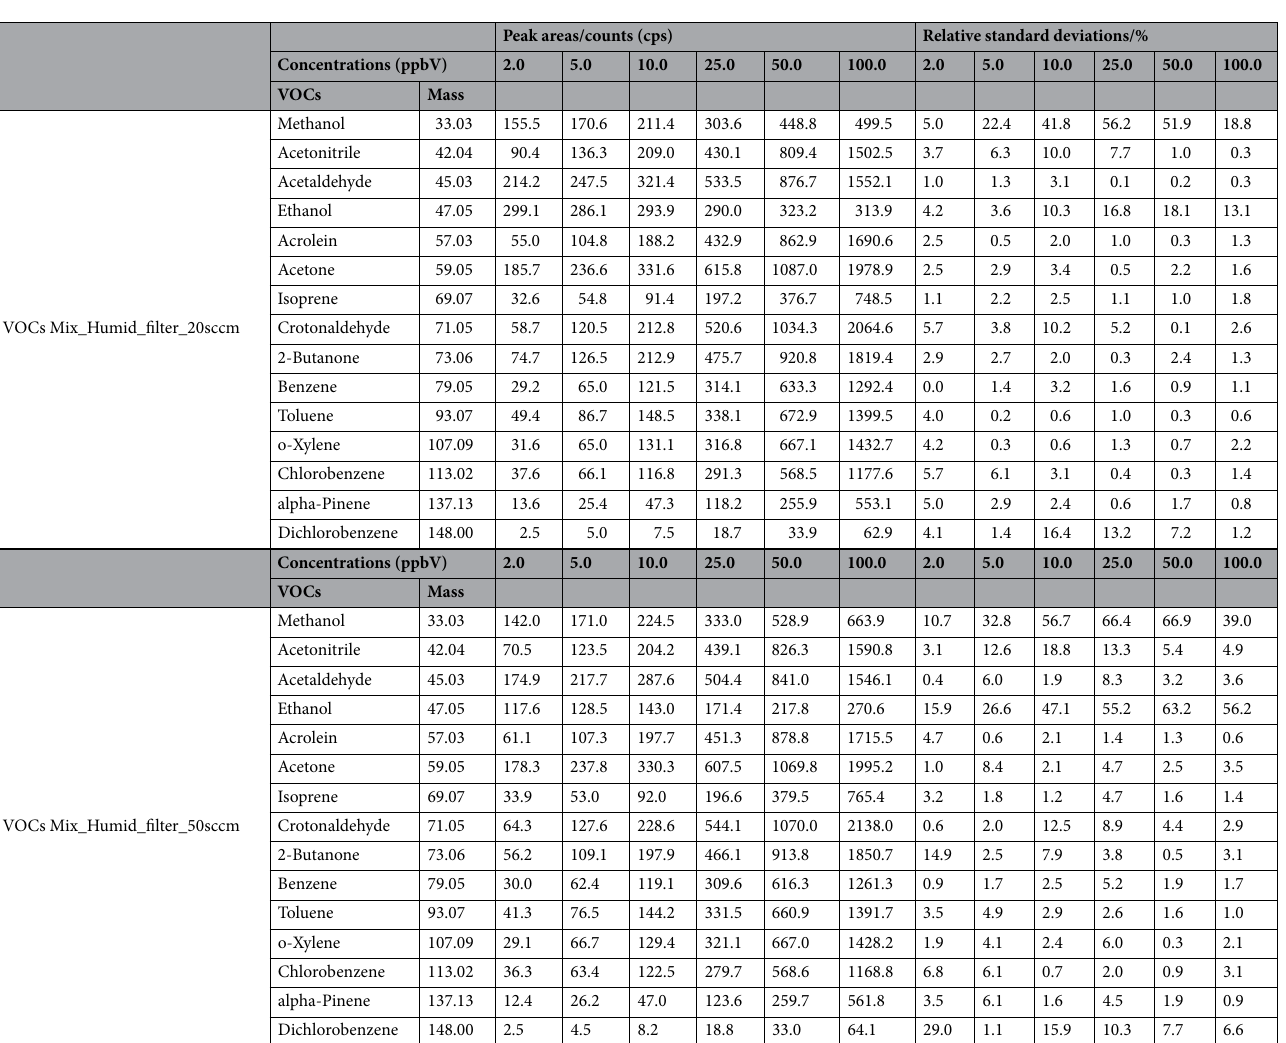
Table 1. VOCs intensities and relative standard deviations (RSDs) from repeated measurements with side- stream syringe filters at two different sampling flow rates. VOCs intensities (cps) along with